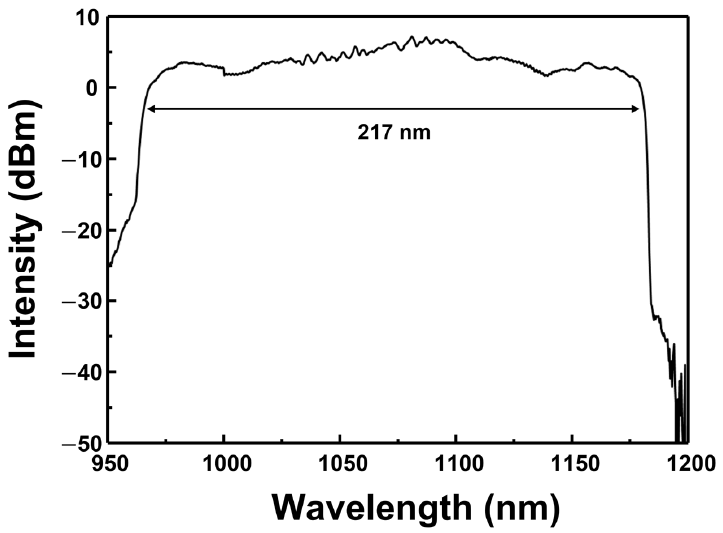
Figure 5. Optical spectra of the WSL.